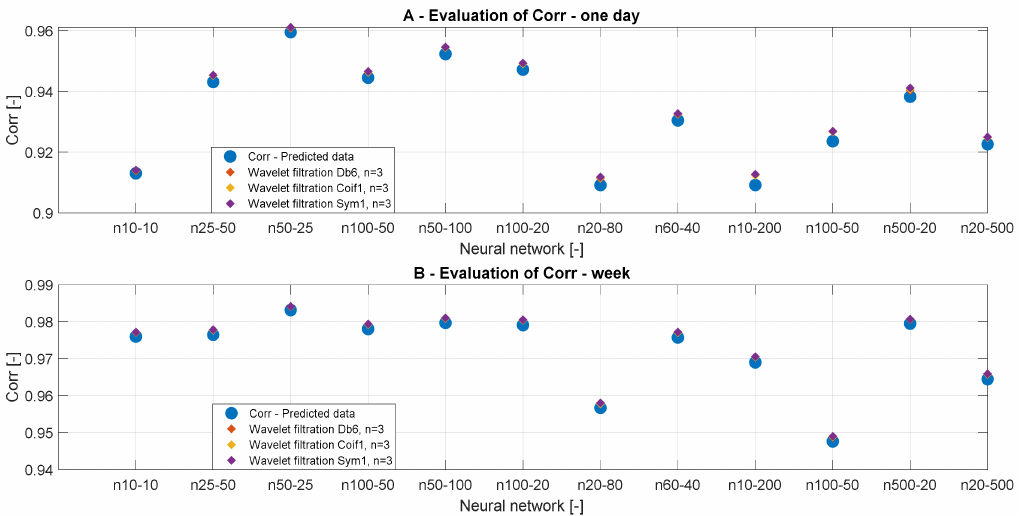
Figure 18. Analysis of correlation values, a comparison for di ff erent wavelets depending on various time periods and the neural network